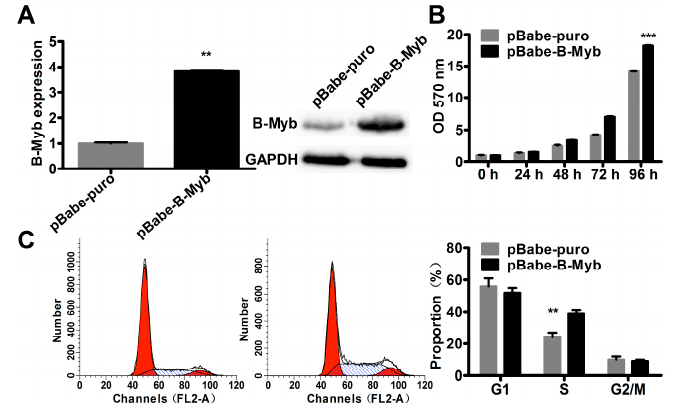
Figure 2. Overexpression of B-Myb promotes lung cancer cell proliferation and cell cycle progression. ( A ) Stable overexpression of B-Myb. H1299 lung cancer cells were transfected with pBabe.puro.GWrfA empty vector and pBabe.puro.GWrfA-B-Myb expression vector. Cells were then